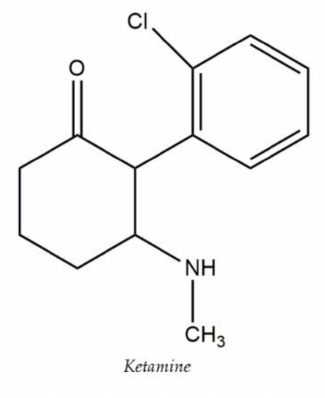
Figure 4. Chemical structures of